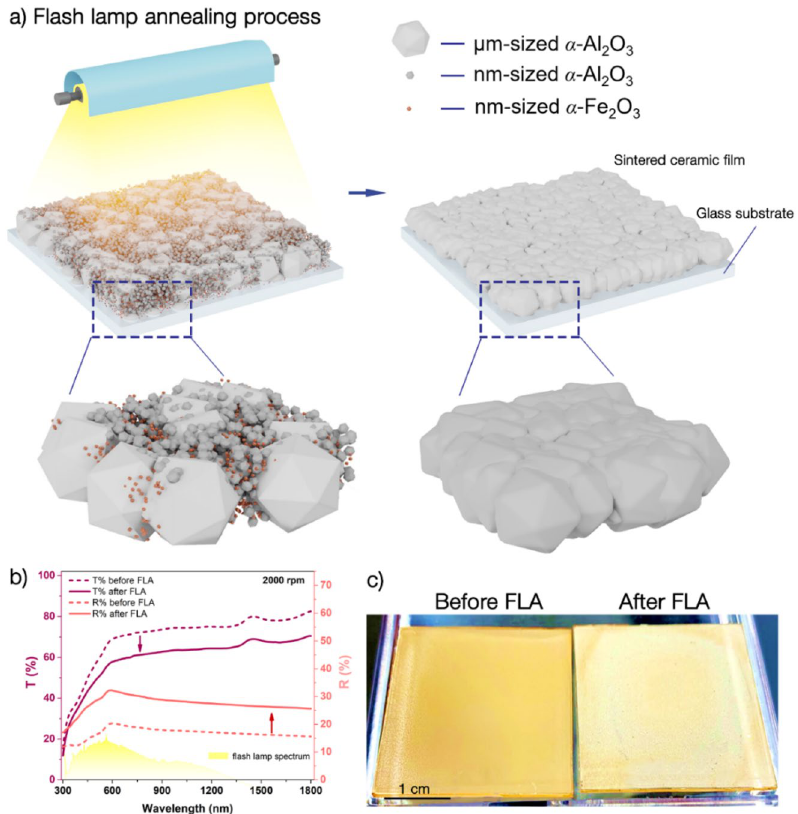
Figure 1. Flash lamp annealing (photonic sintering) process of alumina thin films. ( a ) Schematic illustration of the photonic sintering process of the precursor film, comprised of µm-sized α-Al 2 O 3 , nm-sized α-Al 2 O 3 particles, and nm-sized α-Fe 2 O 3 nanoparticles. ( b ) Optical transmittance and reflectance spectra of ceramic films before and after FLA. ( c ) Photographs of the ceramic films before and after